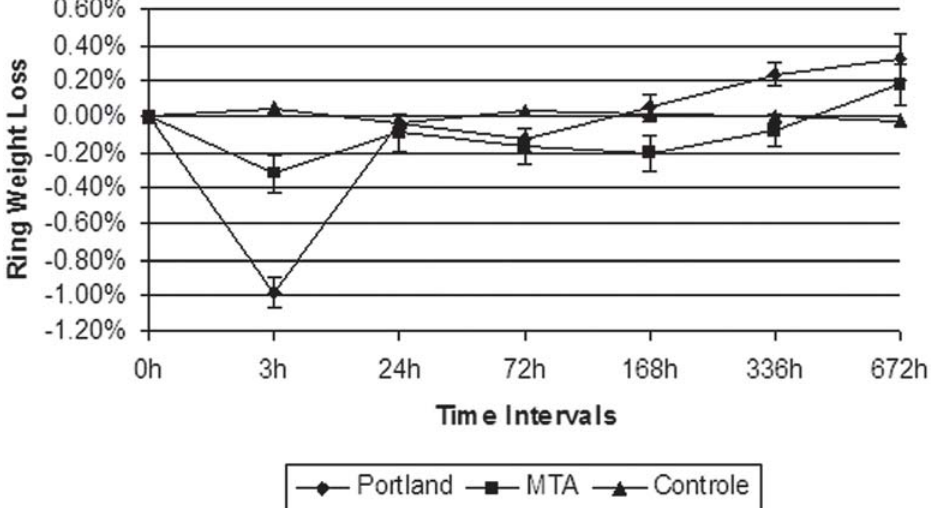
FIGURE 1- Mean weight loss ± standard error of mean of the cements during the experimental intervals determined by the ring weight method